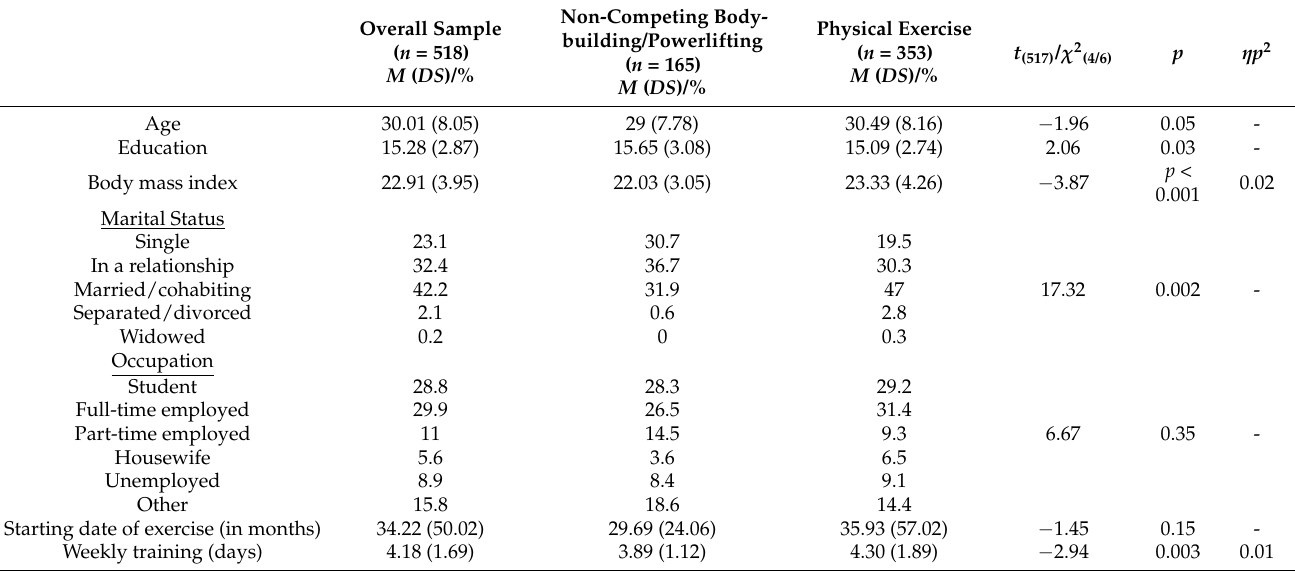
Table 1. Main sample: Descriptive and comparisons between groups on demographics and training